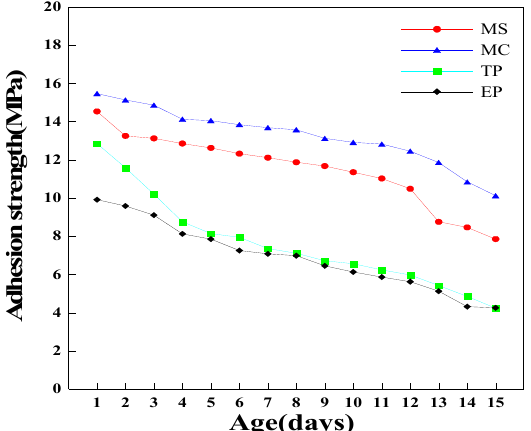
Figure 2. Adhesion strength of coating systems after salt spray test.